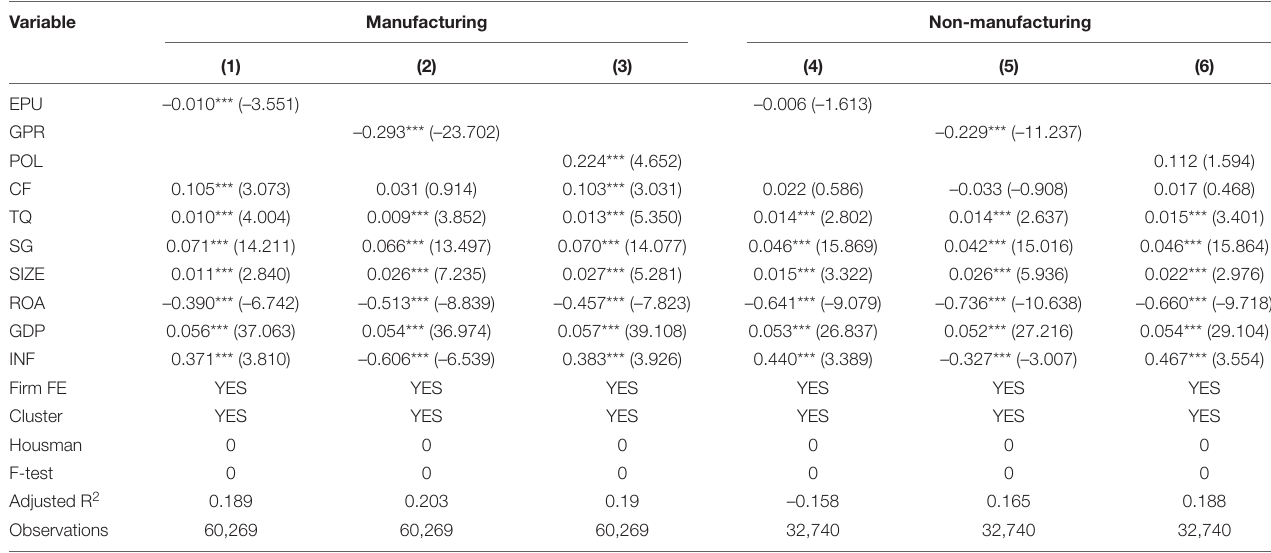
TABLE 7 | Robust checks: manufacturing and non-manufacturing firms. Variable